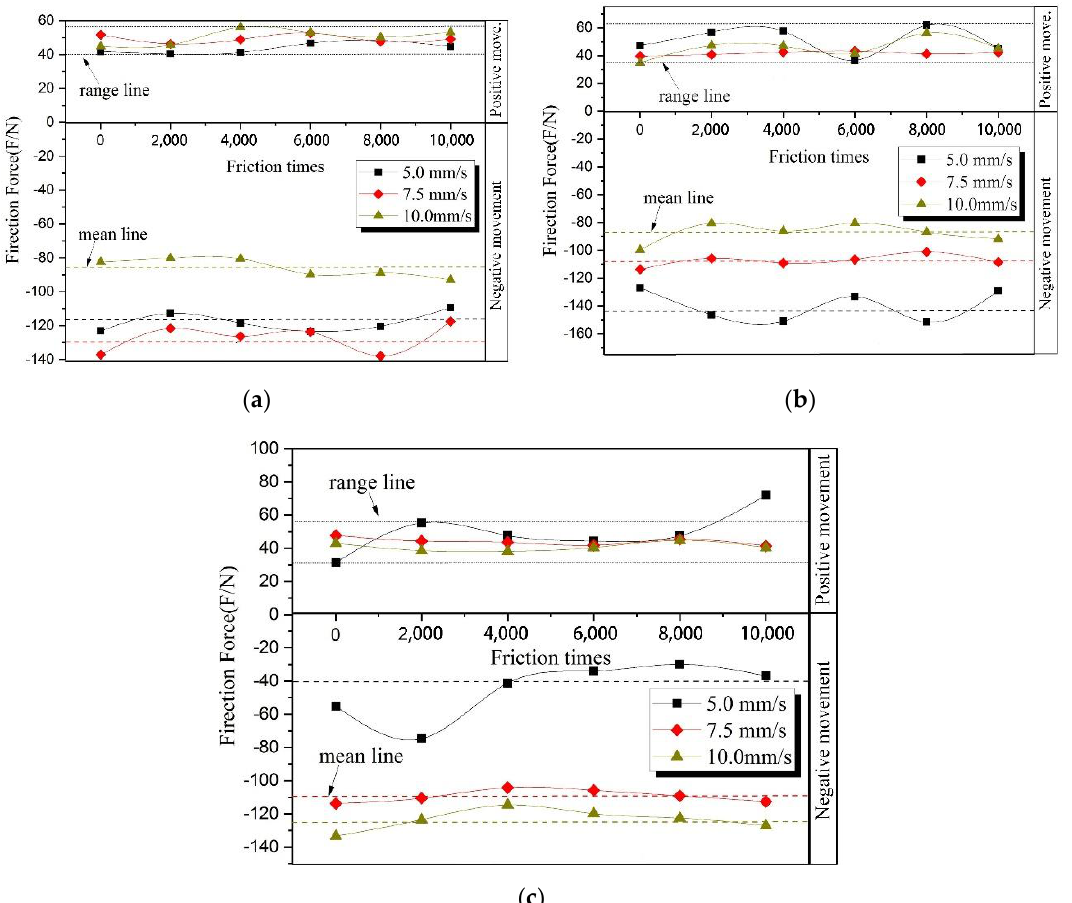
Figure 4. At the different temperature, the relative speed between the cables with the corresponding friction force; ( a ) at 25 °C, ( b ) at 40 °C, ( c ) at 70 °C. Sensors 2020 , 20 , x FOR PEER REVIEW As shown in Figure 4, the vertical axis in the figure represents friction force, and the horizontal axis represents the number of friction times. The positive half-axis of the vertical axis corresponds to the force obtained when the relative movement direction of the cable is positive, and the negative half-axis represents the negative direction.